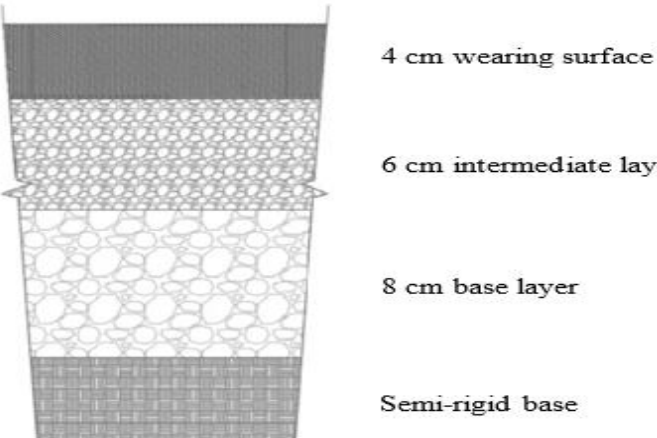
Figure 1. Section of asphalt pavement used in the study.